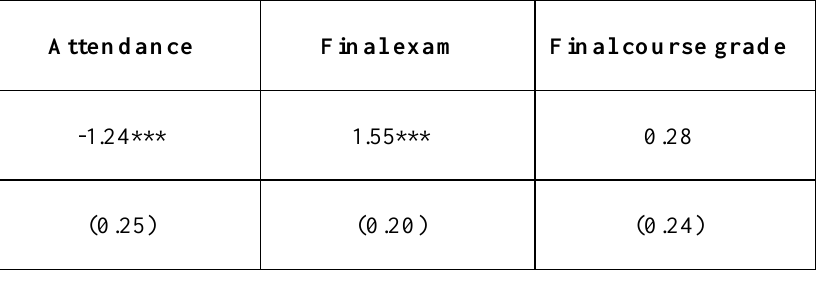
Estimation of the Effect of Using the Khan Academy Collection 1 Versus the Use of Open Textbooks (Scenario 1)